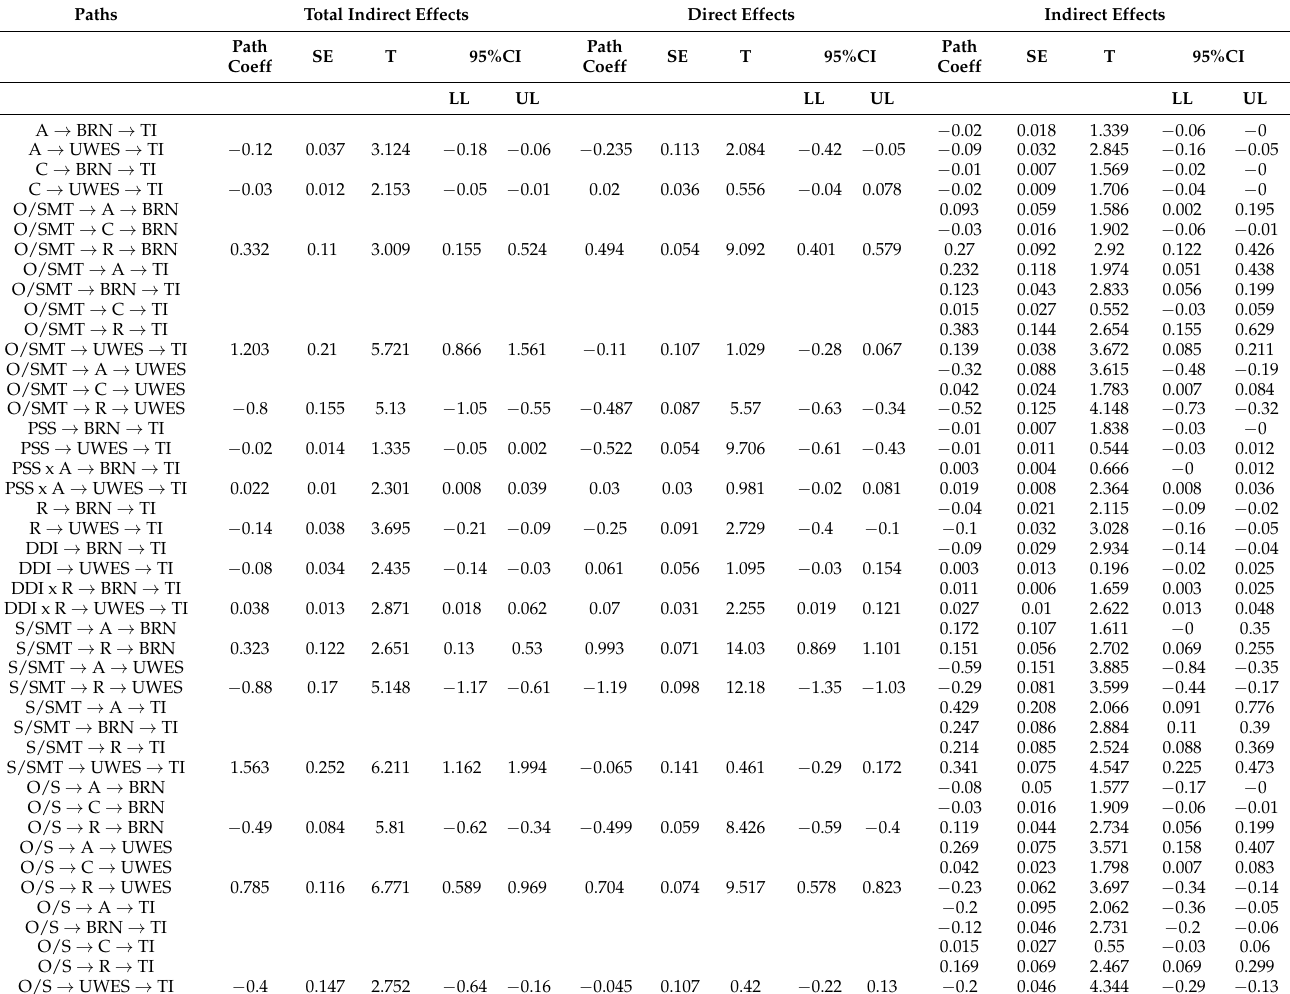
Table A9. Mediation Analyses—Other